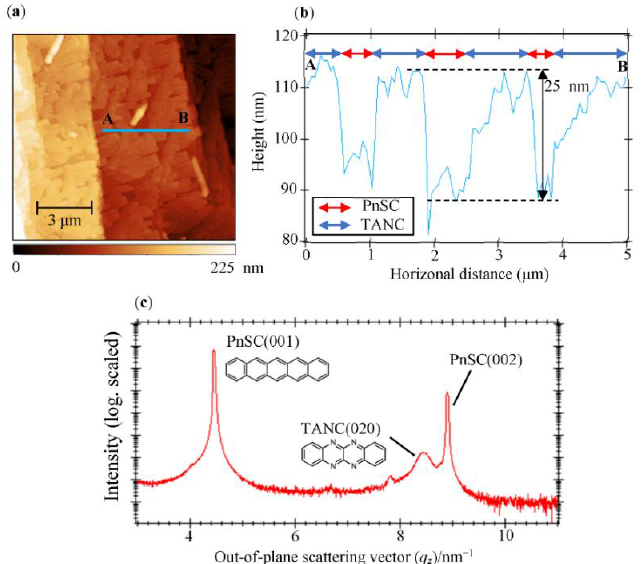
Figure 1. ( a ) 12.5 × 12.5 μm 2 non-contact mode atomic force microscopy (nc-AFM) image of a pentacene single crystal (PnSC) sample with 20 nm-thick 5,6,11,12-tetraazanaphthacene (TANC). ( b ) Cross-section profile along the line A-B in ( a ). ( c ) Out-of-plane X-ray diffraction data of the TANC(20 nm)/PnSC heterojunction. Molecular structures of pentacene and TANC are also given.